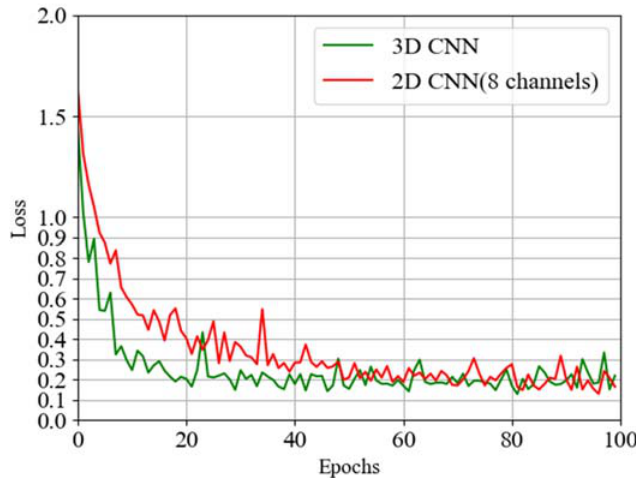
Figure 14. Two loss curves of using only range–Doppler data as input. Table 3. Accuracy and Loss of The Two Networks Using Range–Doppler as Input.